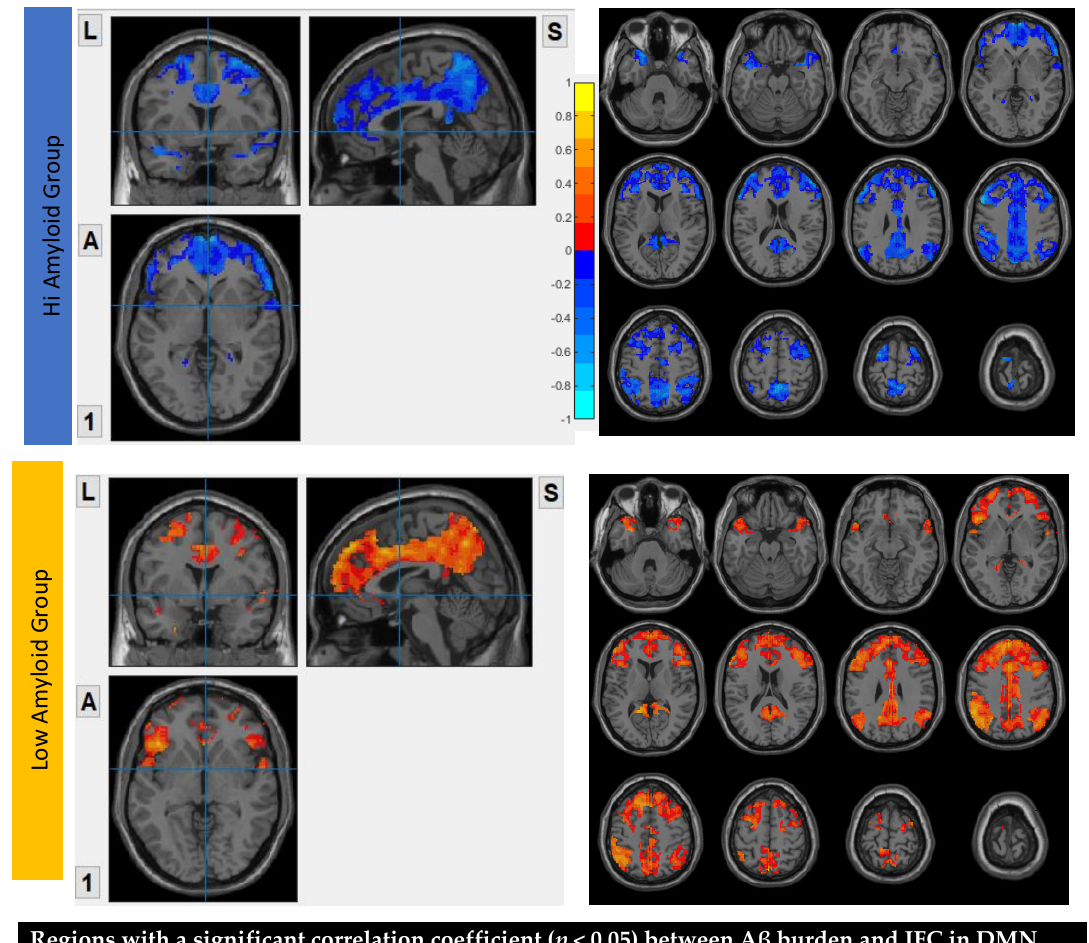
t values according to the scale on the right. VMHC: Voxel Mirrored Homotopic Connectivity. HC: